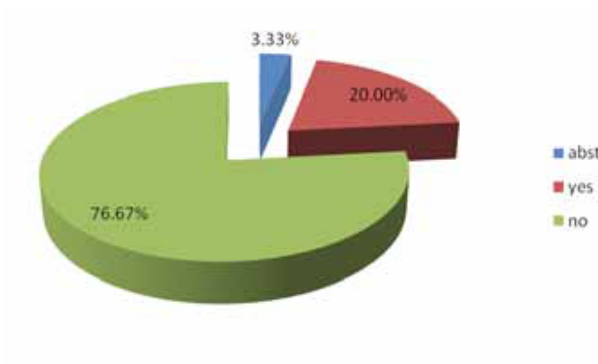
Graph 5: Percentage of Respondent Batik SMEs who knows the administrative requirements for trademark registration at